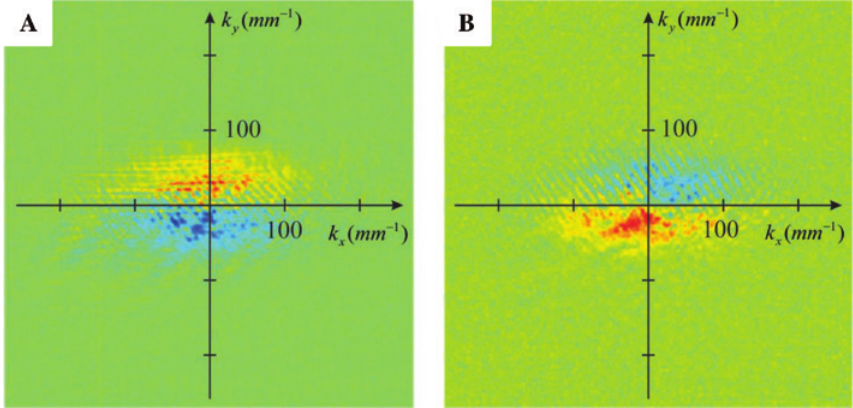
Figure 4: Characterization of spin hall effect. (A) Observation of a giant SHE: the helicity of the anomalously refracted beam. The incidence light is polarized along the x -direction along the phase gradient of the metasurface. The incidence angle is at surface normal. Red and blue represent the right and left circular polariza- tions, respectively. (B) Helicity of the refracted beam with incidence polarized along the y -direction. Reprinted from Ref. [21]. Copyright © 2013 by the